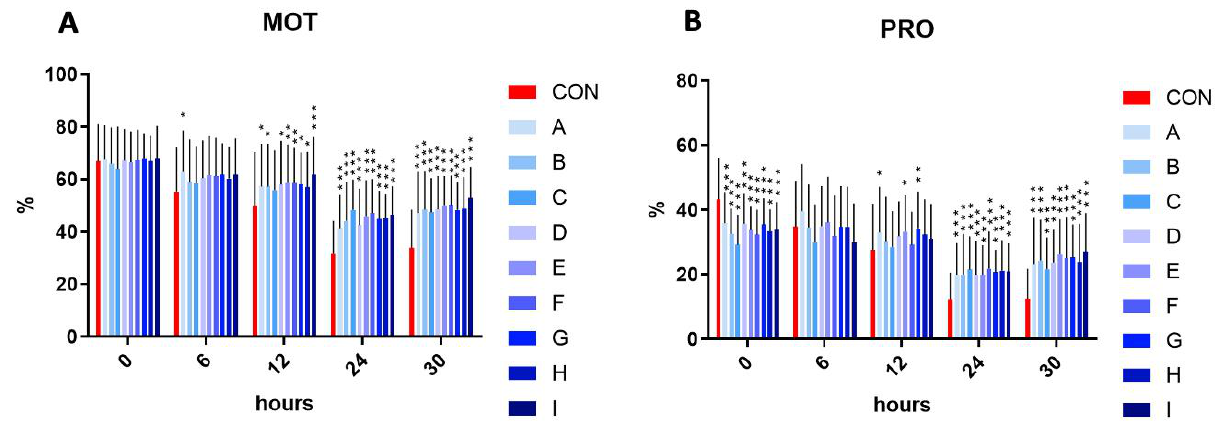
Figure 1. ( A ) The effect of taurine and caffeine on the total spermatozoa motility (%) at 5 °C ( n = 10). ( B ) The effect of taurine and caffeine on the progressive spermatozoa motility (%) at 5 °C. CON: 0 mg/mL taurine + 0 mg/mL caffeine; A: 2.5 mg/mL taurine + 0.625 mg/mL caffeine; B: 2.5 mg/mL taurine + 1.25 mg/mL caffeine; C: 2.5 mg/mL taurine + 2.5 mg/mL caffeine; D: 5 mg/mL taurine + 0.625 mg/mL caffeine; E: 5 mg/mL taurine + 1.25 mg/mL caffeine; F: 5 mg/mL taurine + 2.5 mg/mL caffeine; G: 7.5 mg/mL taurine + 0.625 mg/mL caffeine; H: 7.5 mg/mL taurine + 1.25 mg/mL caffeine; I: 7.5 mg/mL taurine + 2.5 mg/mL caffeine. Each bar represents the mean value of observed samples (±SD). The level of significance was set at *** ( p < 0.001), ** ( p < 0.01), and * ( p < 0.05). The velocity curved line showed significantly decreased values in samples B, I ( p <